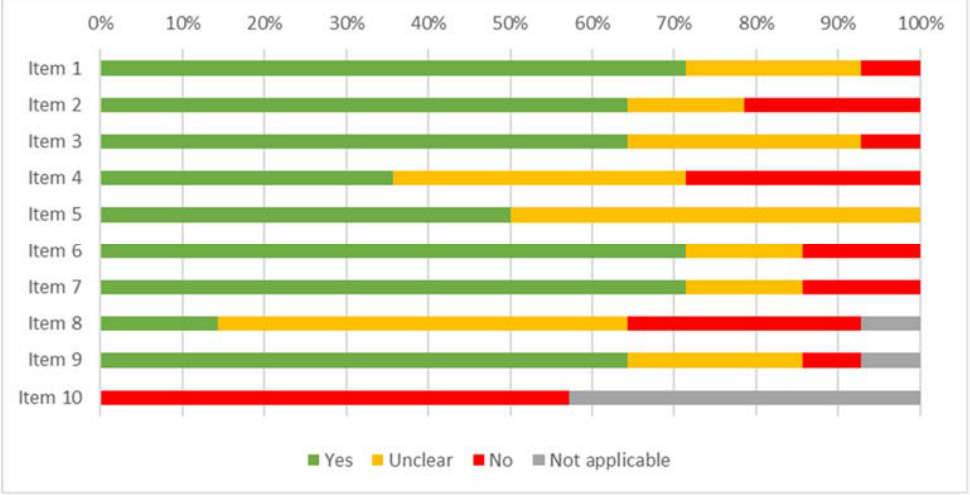
Figure 3. Summary of the critical appraisal process of the case series according to the JBI tools.